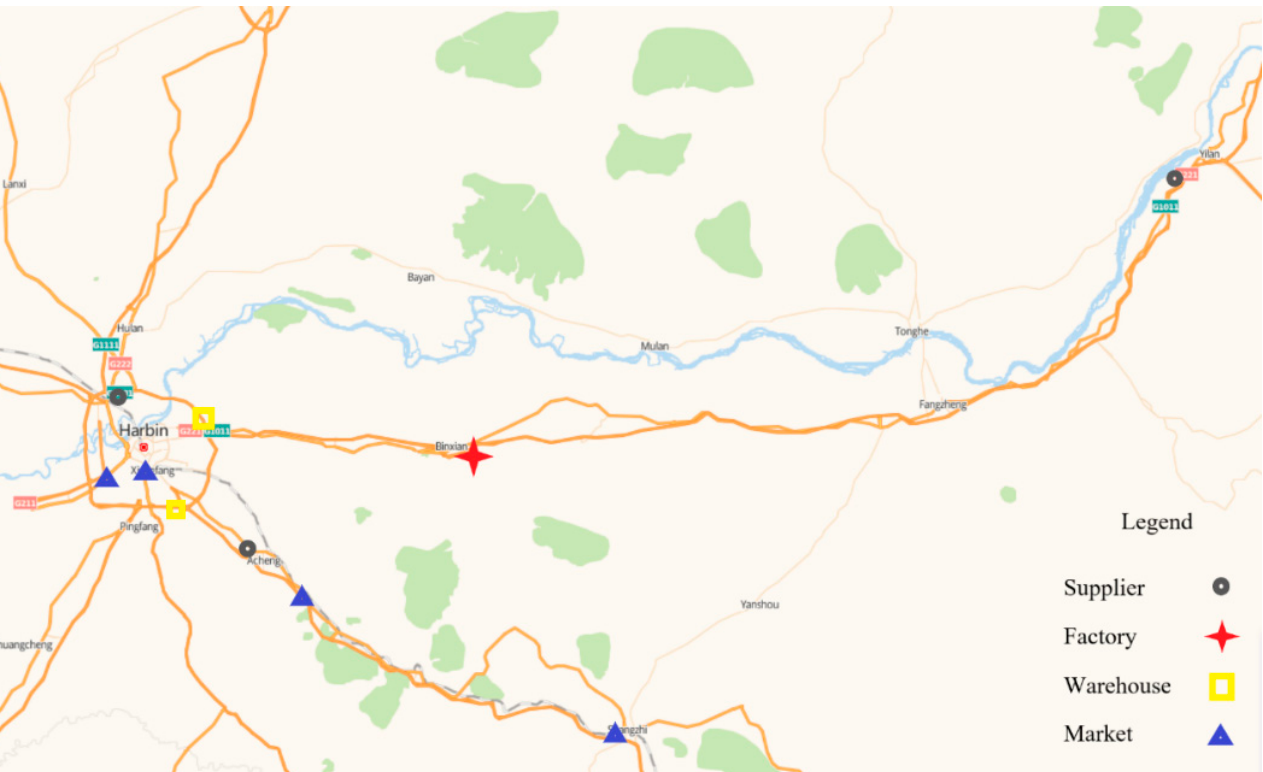
Table 5. Main parameters of suppliers. Parameters